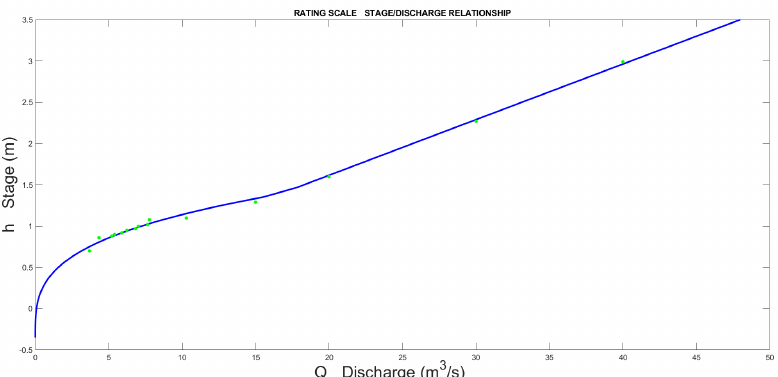
Figure 17. Complete rating scale of Nera with all the input points used for